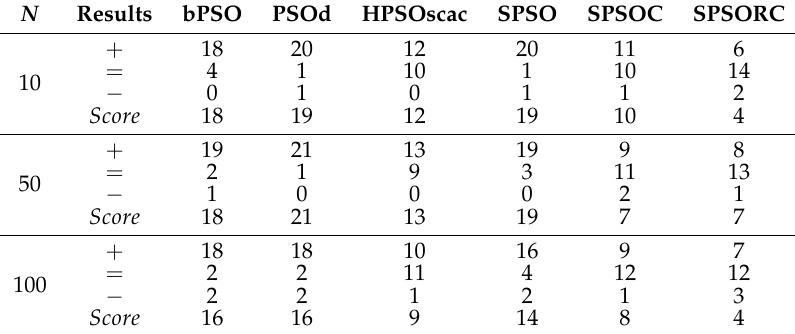
Table 7. Simulation